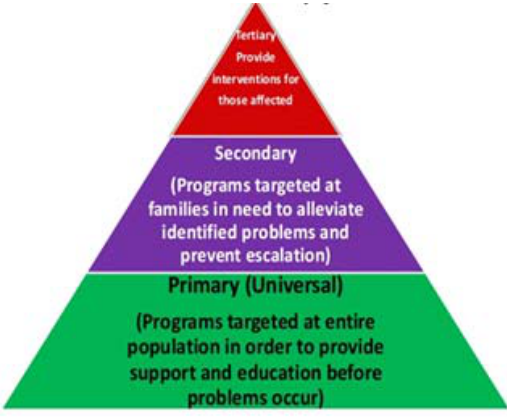
Figure 1. Public health pyramid for preventive